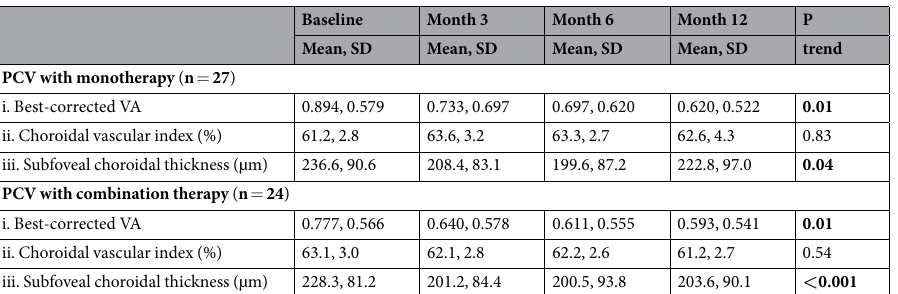
Table 4. The changes in best-corrected visual acuity (BCVA), choroidal vascularity index (CVI) and subfoveal choroidal thickness of PCV eyes according to treatment